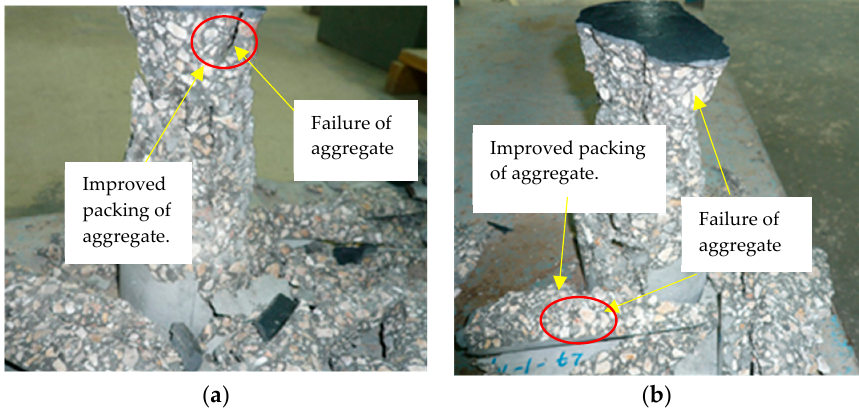
Figure 7. Typical failure of concrete under compression: ( a ) failure of silica fume concrete; ( b ) typical failure of concrete with ultrafines.